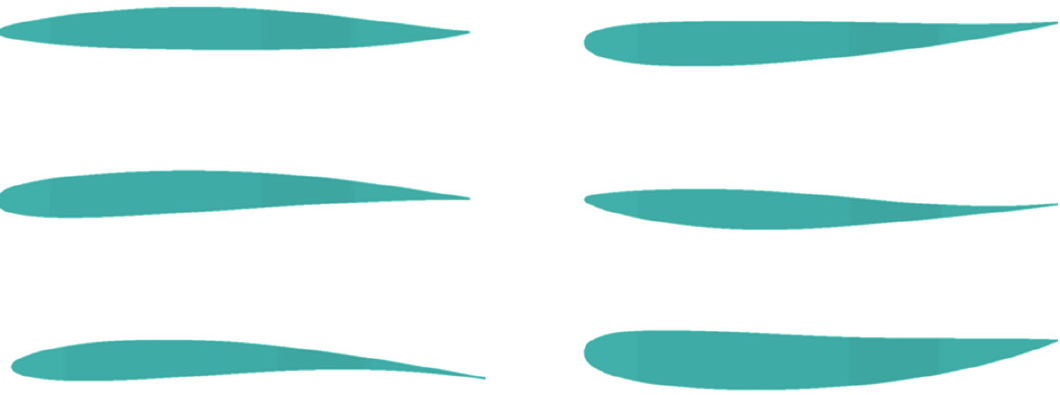
Figure 10: Examples of pylon shapes.